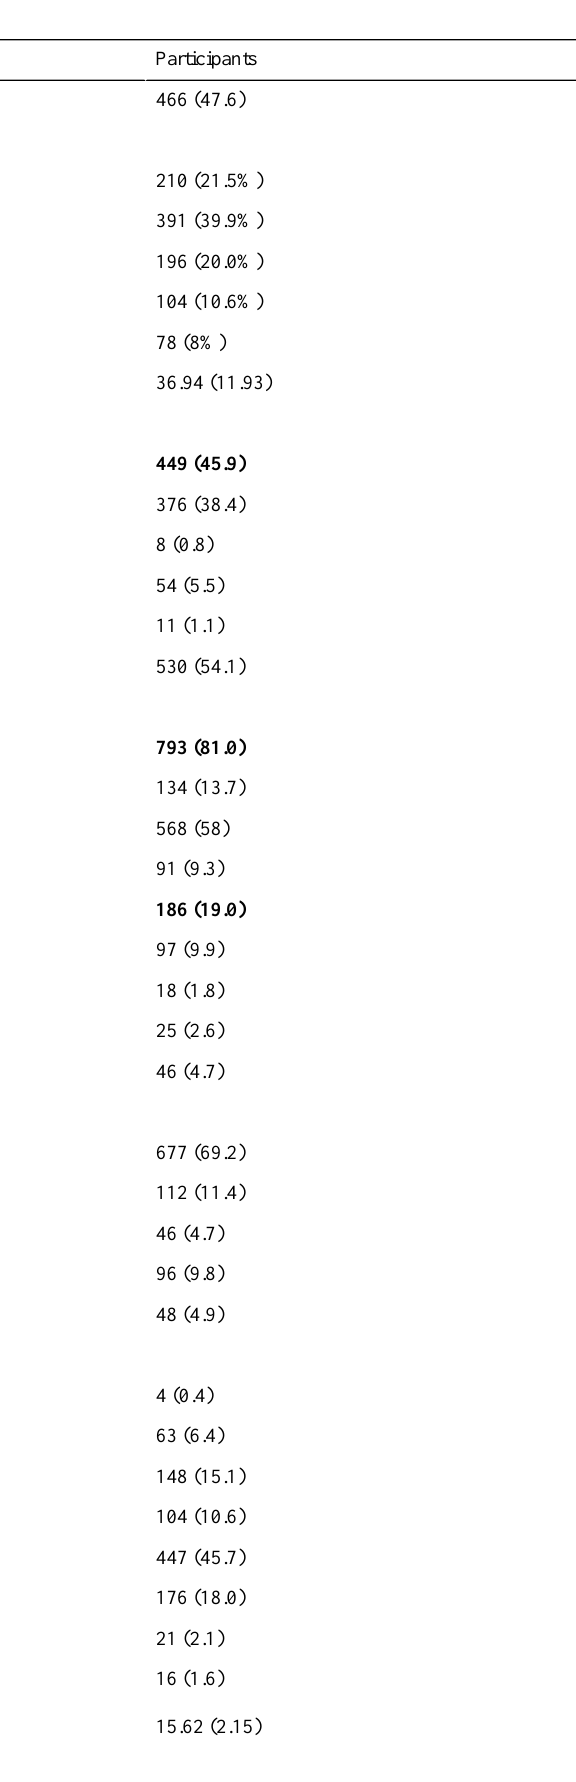
Table 1. Sample characteristics